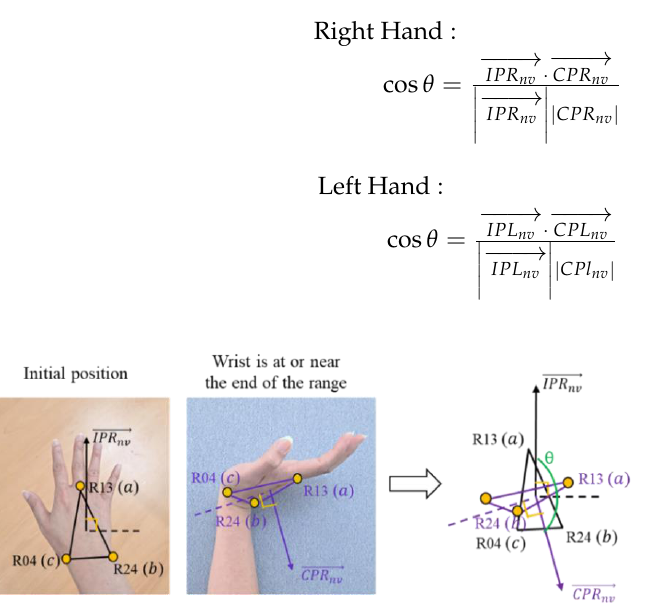
Figure 8. Wrist twist (pronation – supination) angle calculation.